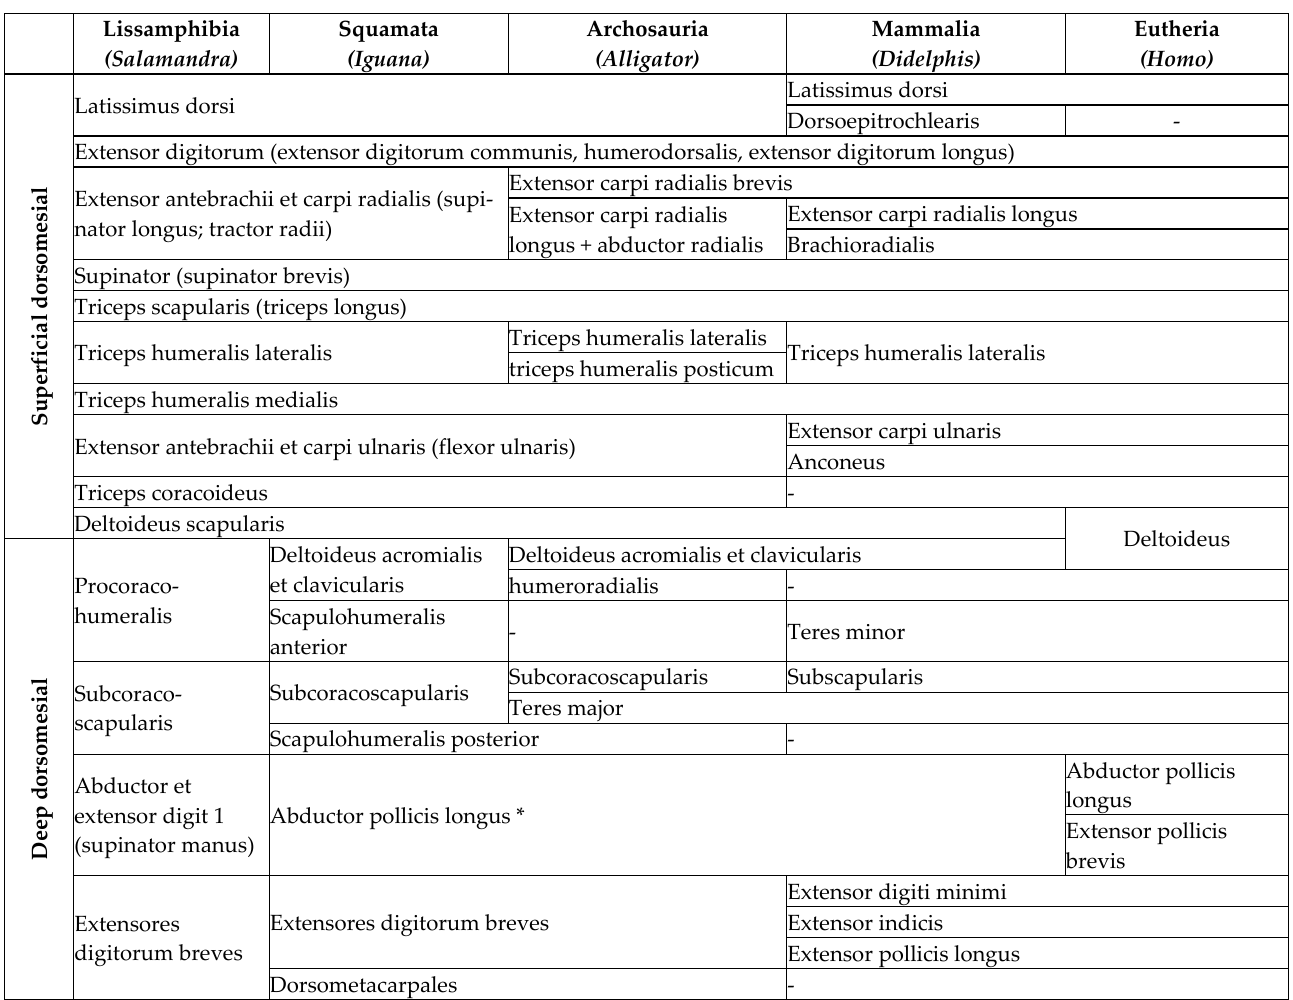
Table A1. Evolution and homologies of tetrapod forelimb muscles. Muscles listed in each column are usually plesiomorphically present in that taxonomic group (bold), and they are present in that particular genus (italics). Muscles are organized by developmental group (first column). Muscles in the same row with different names indicate partial homology resulting from muscle splits or fusions. Synonyms in parentheses. * Indicates controversial or uncertain homologies. Modified from Diogo et al. [37].